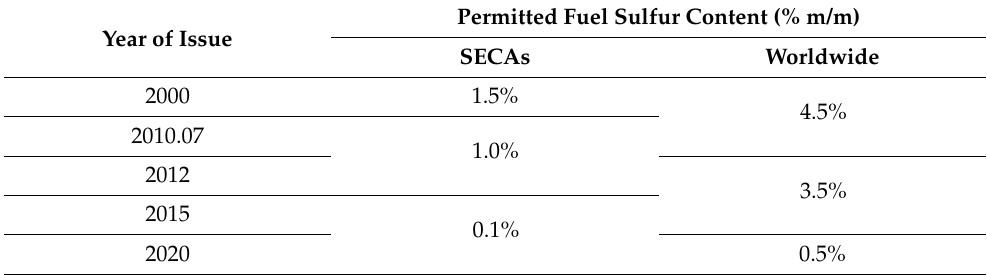
Table 1. Marine fuel sulfur contents that have been legislated by the International Maritime Organi- zation (IMO) according to the MARPOL Annex VI and are effective in both SO x Emission Control Areas (SECAs) and globally. (Table was genuinely generated using data from ref.